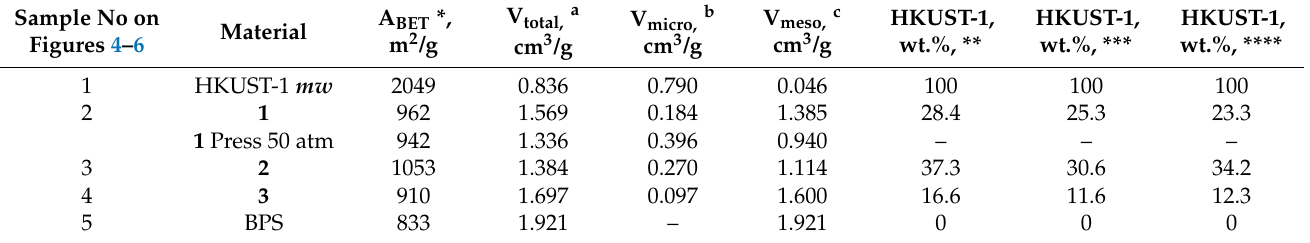
Figure 4. N 2 adsorption isotherms at 77 K for the HKUST-1@BPS composites, the HKUST-1 mw reference sample, and the bare BPS matrix. Table 1. Textural characteristics of the HKUST-1@BPS composite materials and the HKUST-1 mw reference